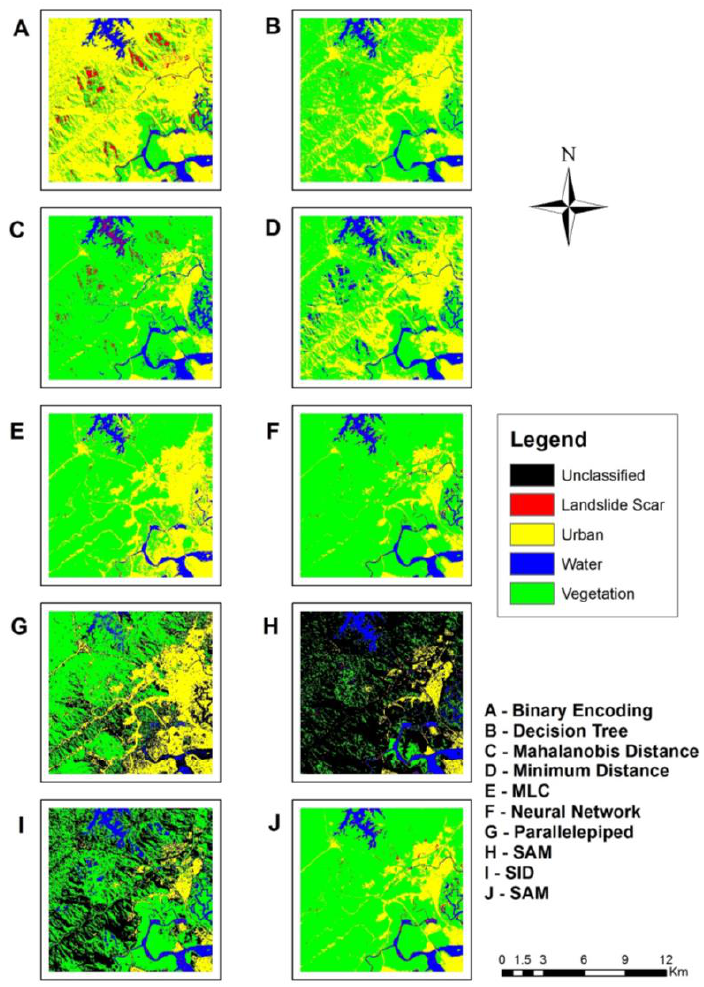
Figure 4. Classification maps for each algorithm. ( A ) Binary Encoding; ( B ) Decision Tree;